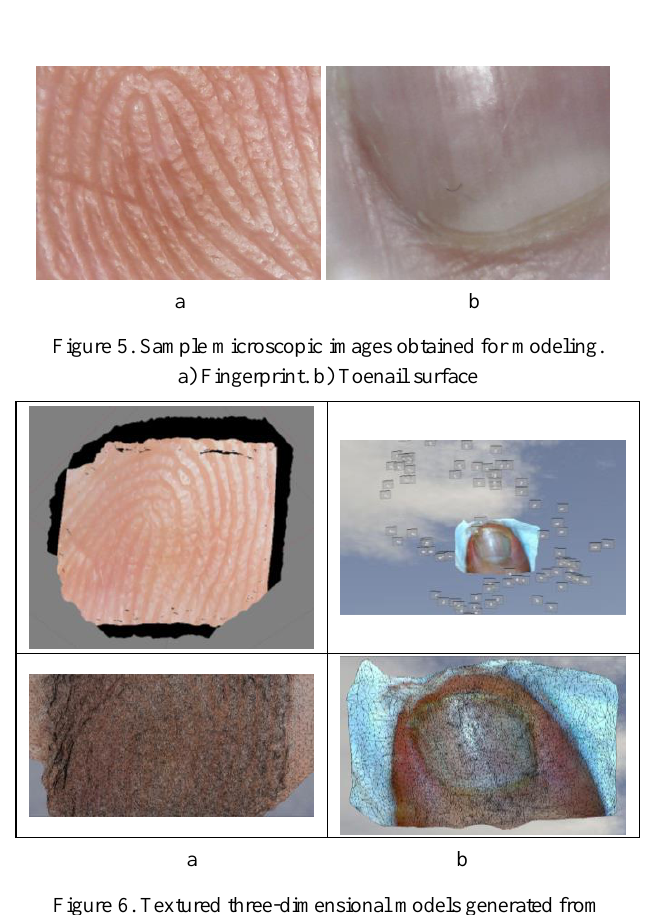
Figure 6. Textured three-dimensional models generated from the objects under investigation. a) Fingerprint. b) Toenail